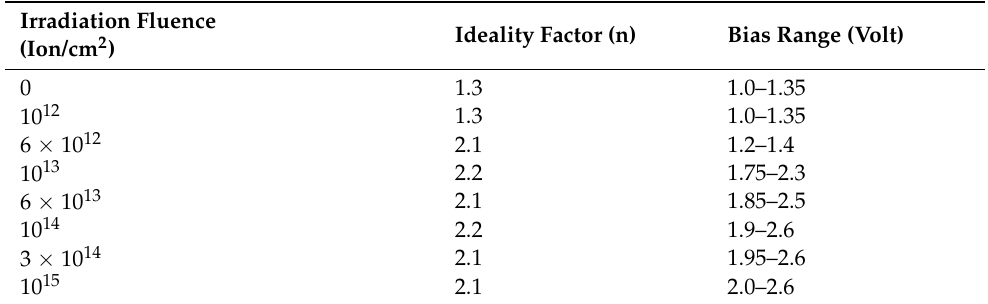
Table 1. Ideality factor (n) for sample irradiated at different fluences calculated in the reported bias range.